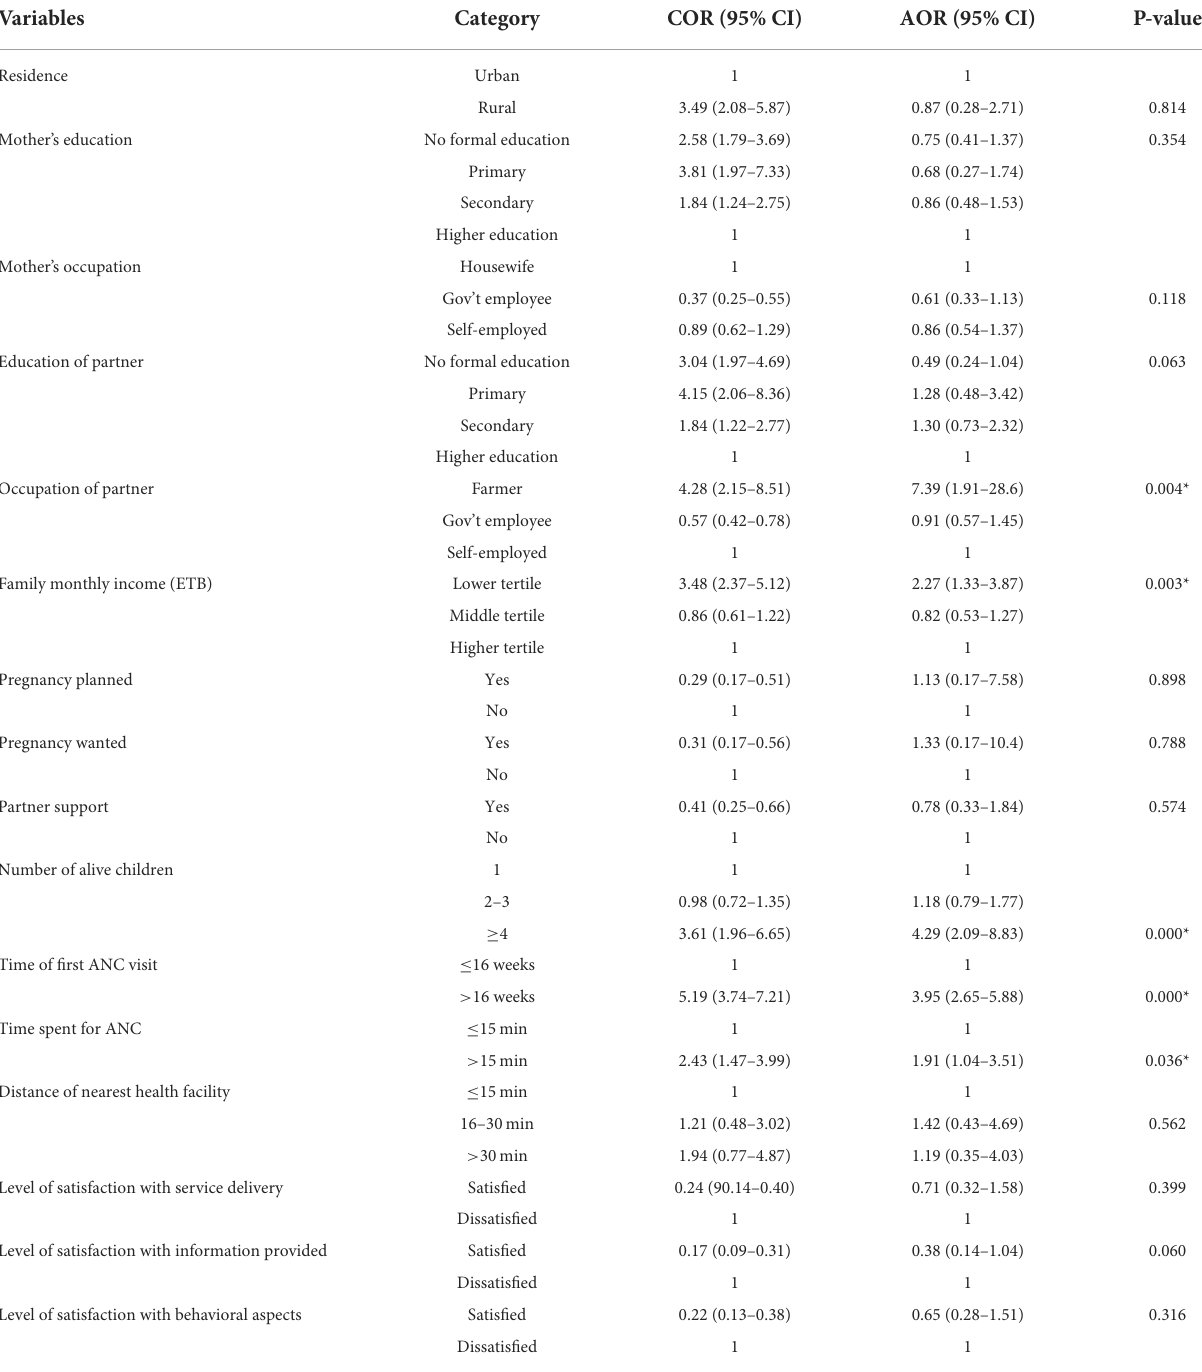
TABLE 6 Factors associated with dropout from maternity care continuum in northeast